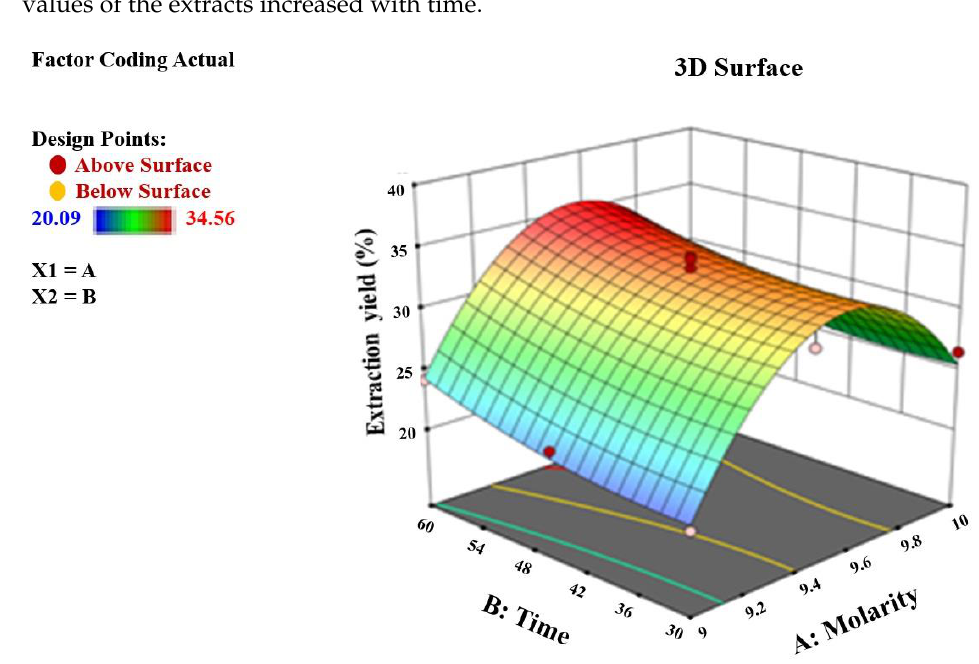
Figure 2. The interaction effect of the extraction variables on the yield of CNCs.